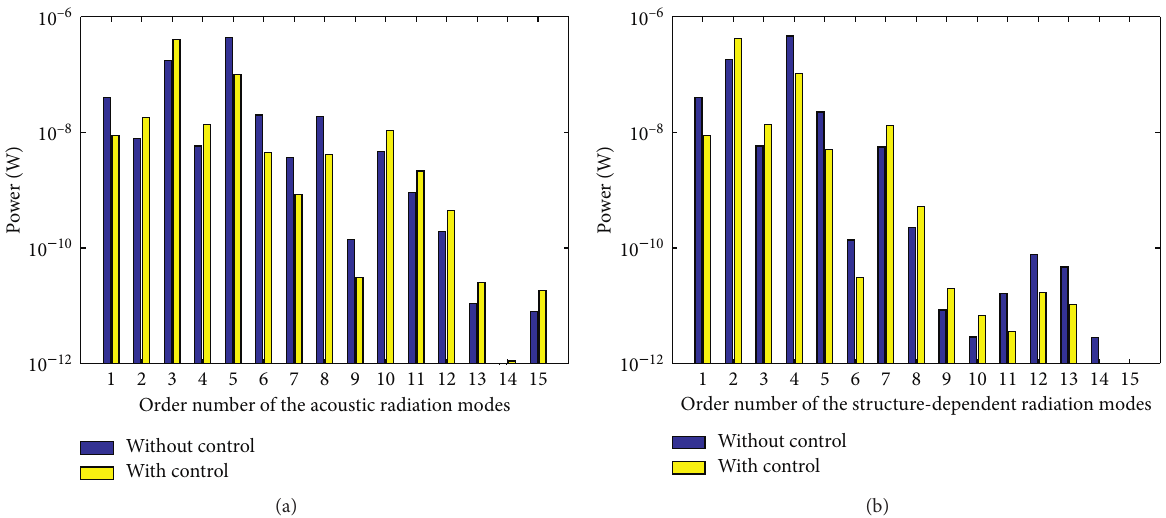
Figure 9: Sound power of the a -modes and s -modes at nonresonance frequency (500 Hz). (a) Sound power of the a -modes. (b) Sound power of the s